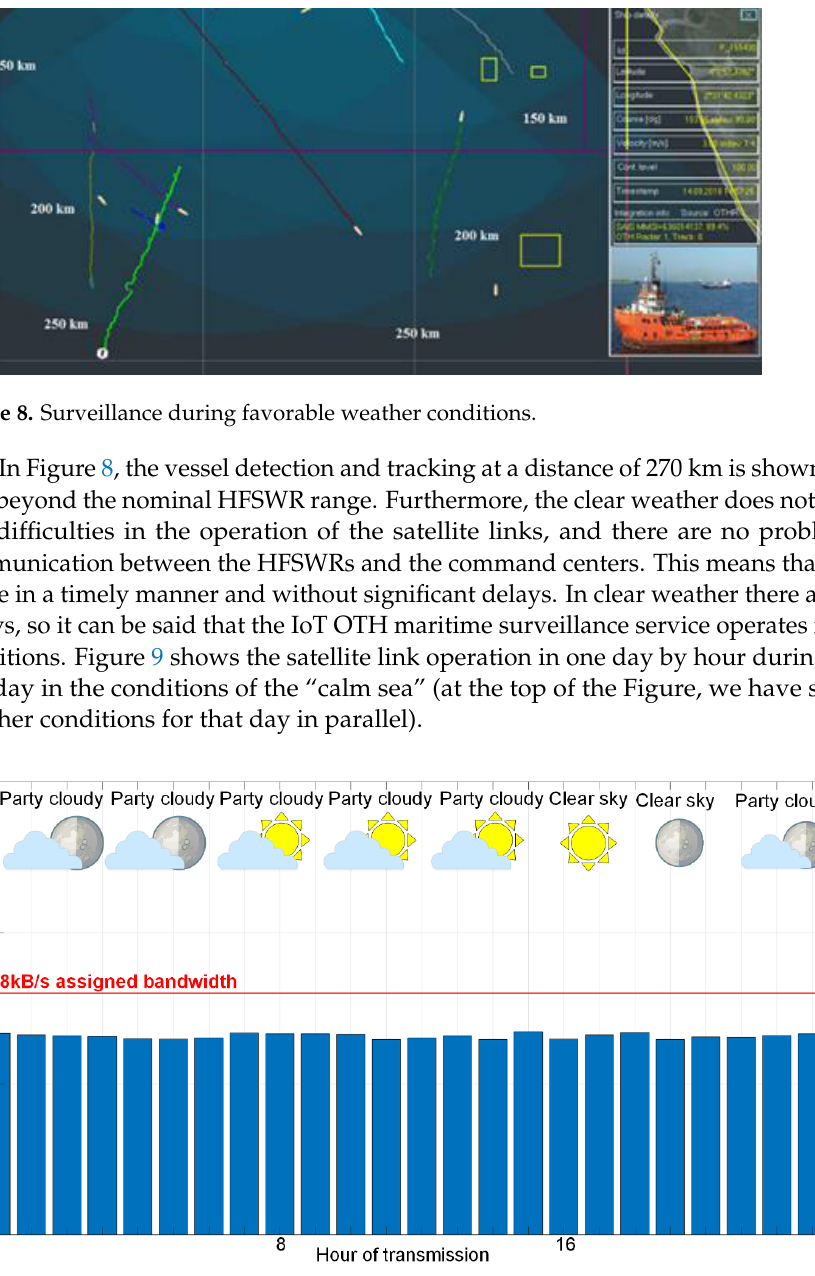
Figure 10. Bad weather conditions over part of the HFSWR surveillance area. As it can be seen from Figure 10, the storm does not cover the coast itself, but “only” a large part of the HFSWR coverage area. Under these weather conditions, the range of